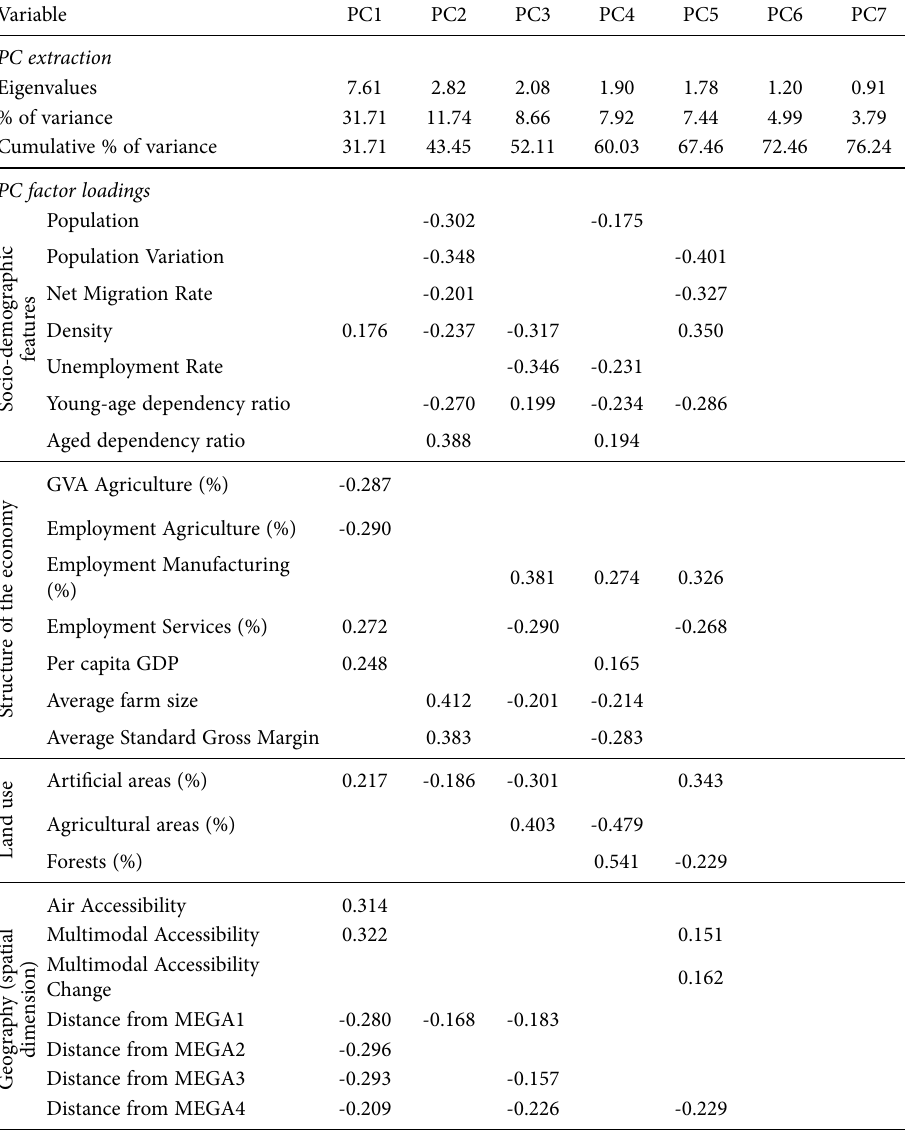
Table 2. PC extraction (eigenvalues and variance explained of the first 7 PCs) and factor loadings (only significant values, ≥ |.15|, are